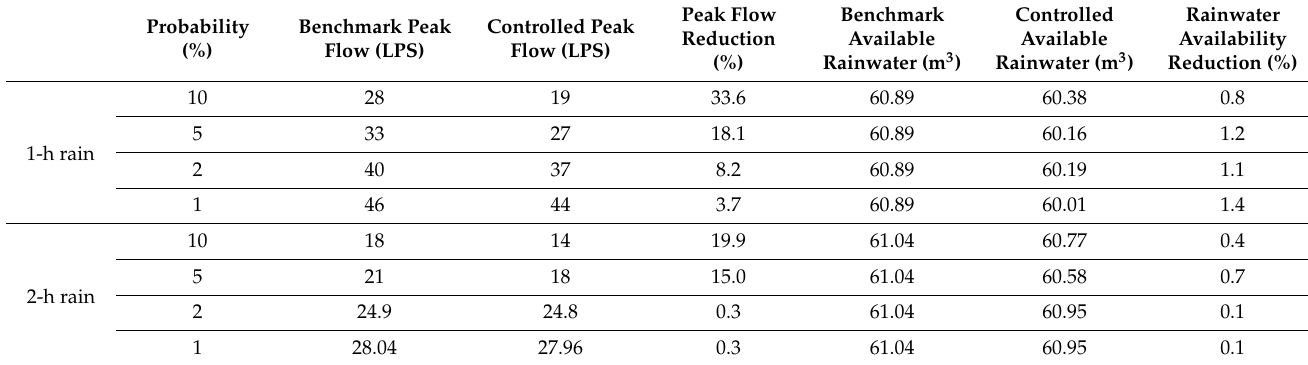
Table A1. Results of applying the optimization method on constant rain intensities from the Beit Dagan IDF curve.